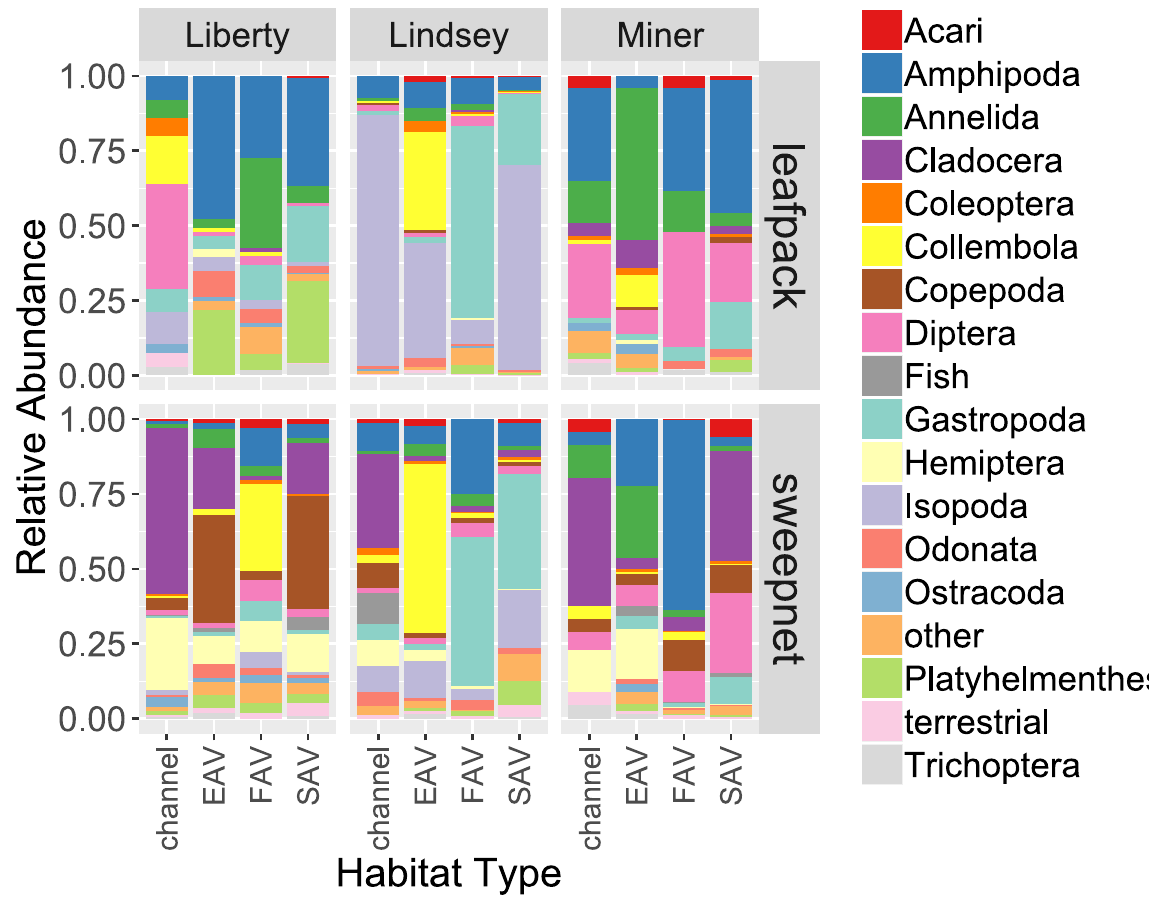
Fig 4. Relative abundance of major taxa in samples collected with leaf packs and sweep nets in various habitats in the three different areas (Liberty, Lindsey, and Miner). Taxa that made up less than 0.5% of the total catch were combined into the “other” category to simplify the graph. PERMANOVA showed significant differences between habitat types, between areas, and between sample types (Table 5). The “fish” category included juvenile sunfish (family Centrarchidae), Mississippi silversides ( Menidia beryllina ), and gobies (genus Tridentiger ), all non-native